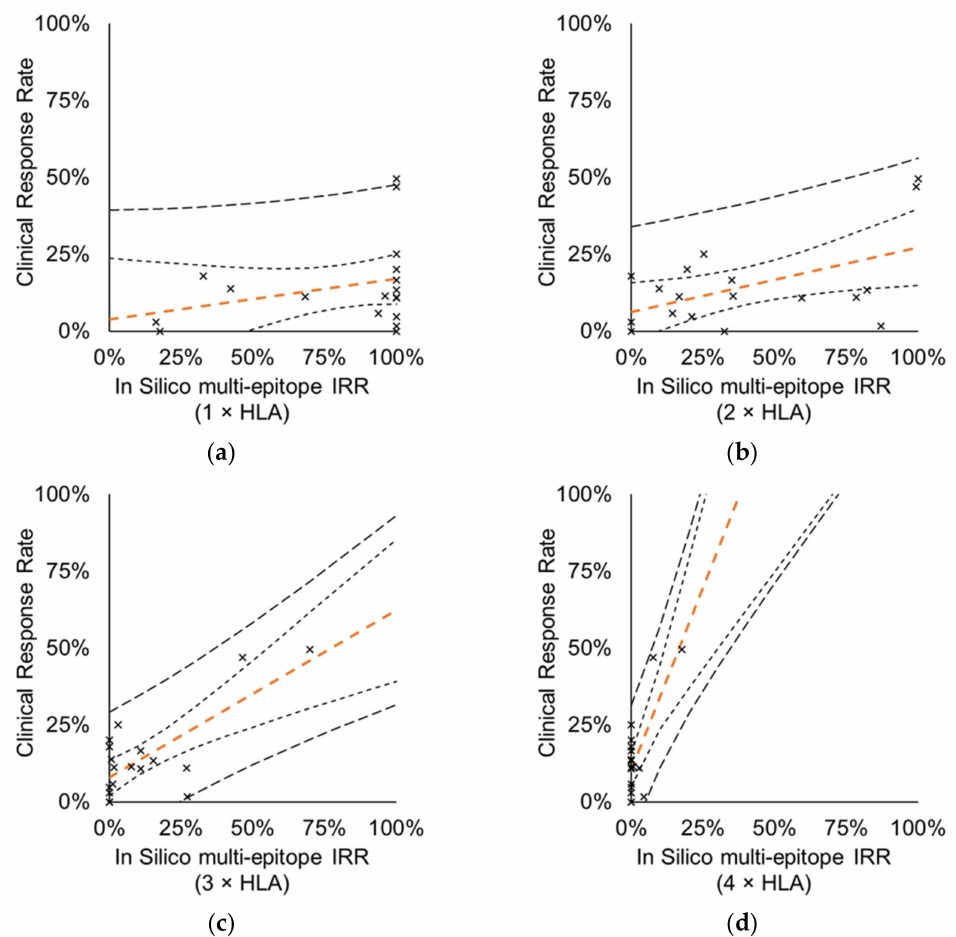
Figure 7. Correlation between CRRs measured by CTs and in silico multi-epitope IRRs of multiantigen-targeting vaccines. Analysis included 23 CTs with 16 vaccines, total of 18 data points. Prediction of multi-epitope IRRs is based on the frequency of subjects in the MP with at least two vaccine-specific epitope that are ( a ) restricted to ≥ 1 autologous HLA class I allele ( r = 0.2909, p = 0.2415), ( b ) restricted to ≥ 2 autologous HLA class I alleles ( r = 0.5253, p = 0.0252), ( c ) restricted to ≥ 3 autologous HLA class I alleles ( r = 0.7463, p = 0.0004), ( d ) restricted to ≥ 4 autologous HLA class I alleles ( r = 0.7462, p = 0.0004). Orange dashed line: perpendicular trend line with 95% confidence interval band (95% prediction interval band is shown by thicker dashed